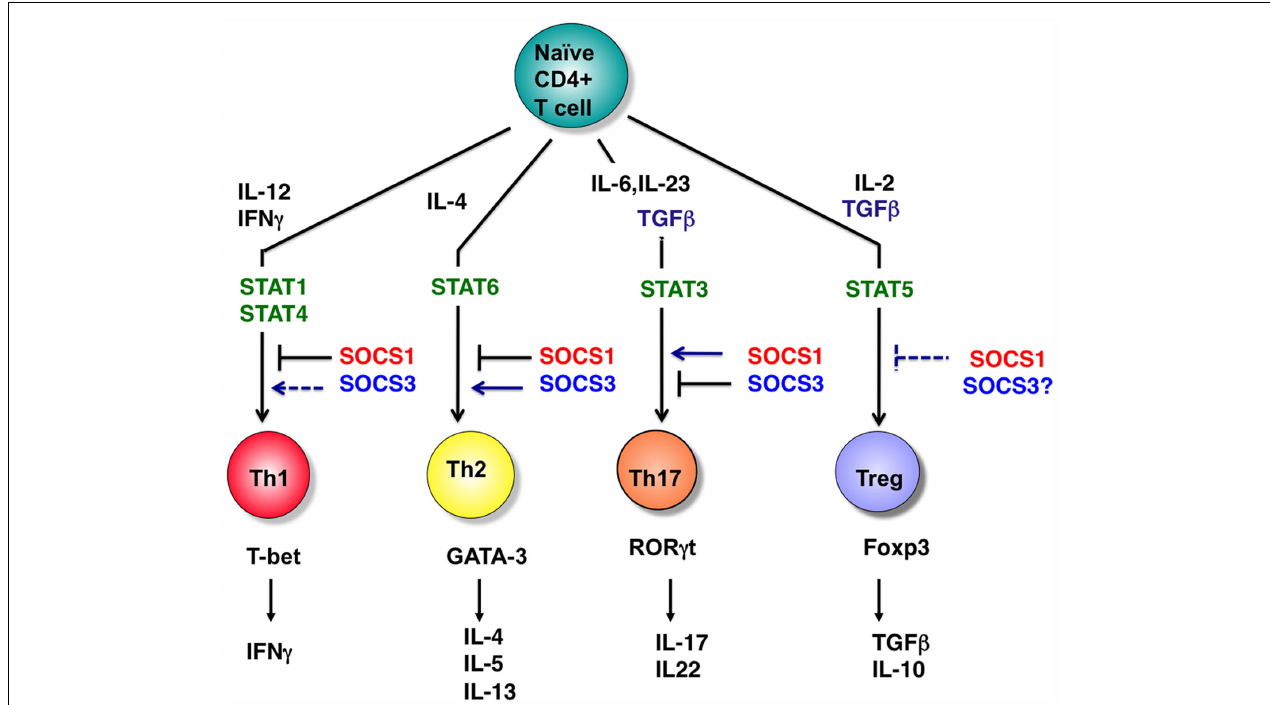
FIGURE 3 | Role of STATs and SOCS proteins in helperT cell differentiation. T cell differentiation from naïve cells into the various functional subtypes (e.g.,Th1,Th2,Th17, andT reg cells) primarily depends on the action of cytokines as indicated. SOCS1 and SOCS3 regulate the cytokine pathways indicated, and thereby dictate CD4 + T cell differentiation. Note that SOCS3 inhibitsTh1 through overexpression by suppressing IL-12 mediated